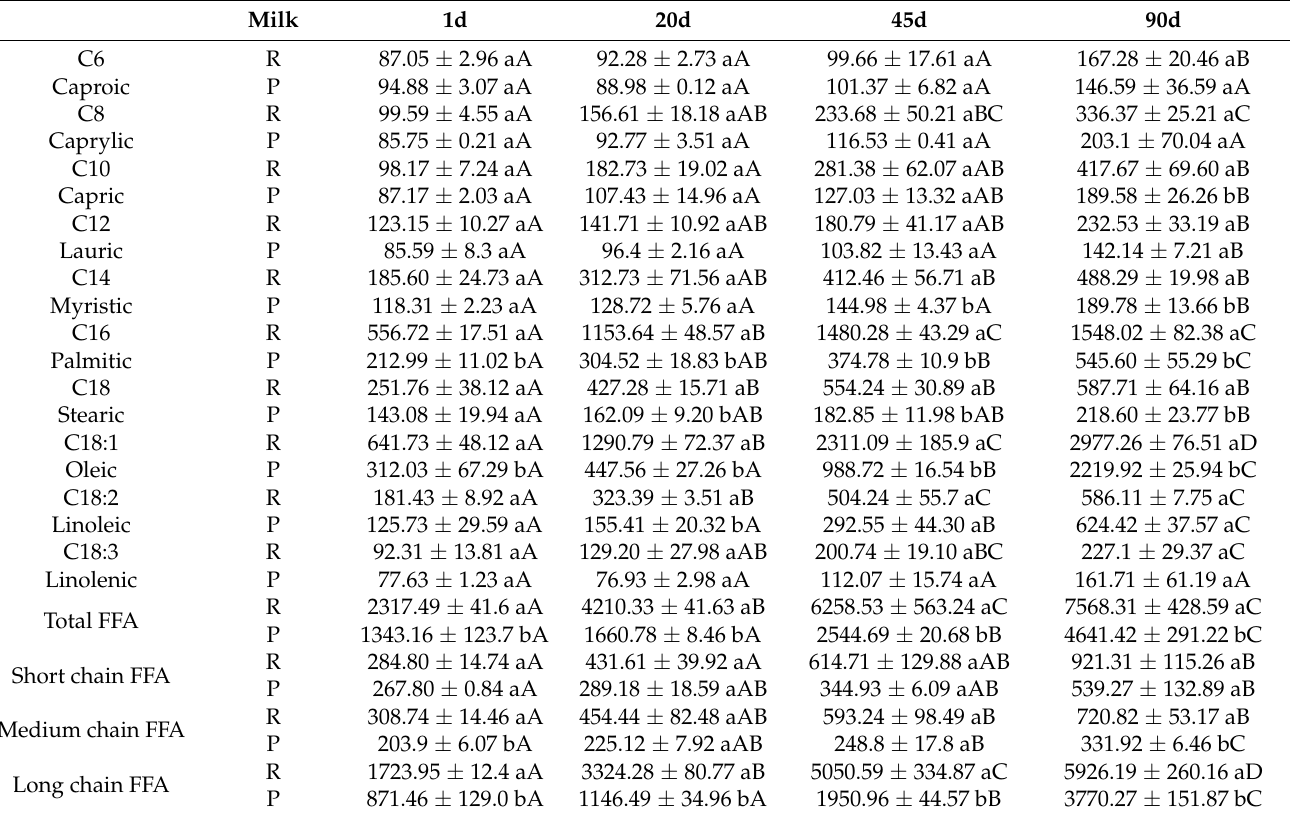
Table 7. Free fatty acid content (mg/kg) of hard Xinotyri cheese made from raw (R) or pasteurized milk (P) during ripening and storage (i)